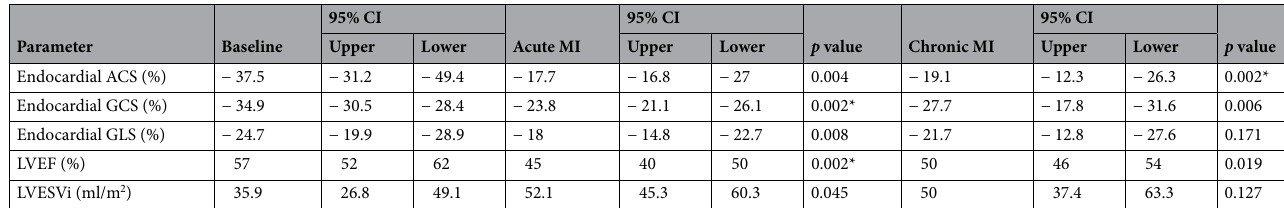
Table 1. Changes in myocardial strains over time. CI = Confidence interval; ACS = Apical circumferential strain; GCS = Global circumferential strain; GLS = Global longitudinal strain; LVESVi = Left ventricular end-